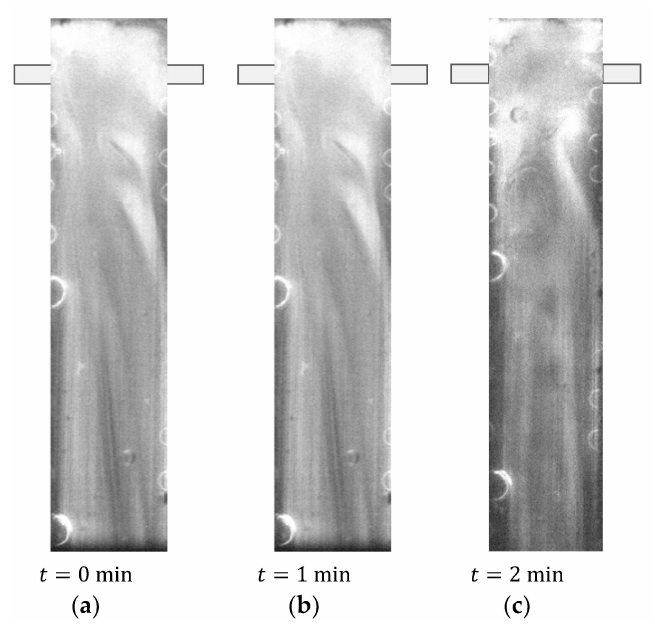
Figure 10. PLIF image from Oxi-RPLIF method at Re = 50.